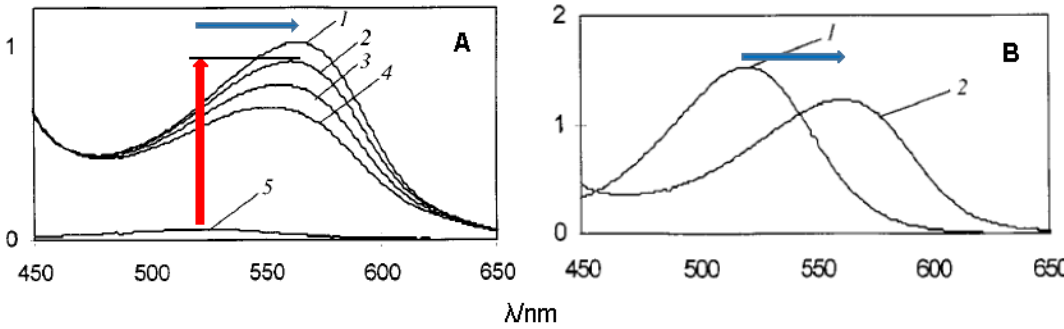
Figure 12. Co-pigmentation of malvin (malvidin 3,5-diglucoside, 50 µM) by rutin bis(hydrogensuccinate) (mixture of 3 regioisomers, 200 equiv.). ( A ) pH = 3.5, malvin + co-pigment at T = 15.5 (1), 25.0 (2), 35.0 (3), 44.2 (4) °C, malvin alone at T = 25.3 °C (5). ( B ) pH = 0.9, T = 25.0 °C, malvin alone (1), malvin + co-pigment (2). Adapted from reference [35].